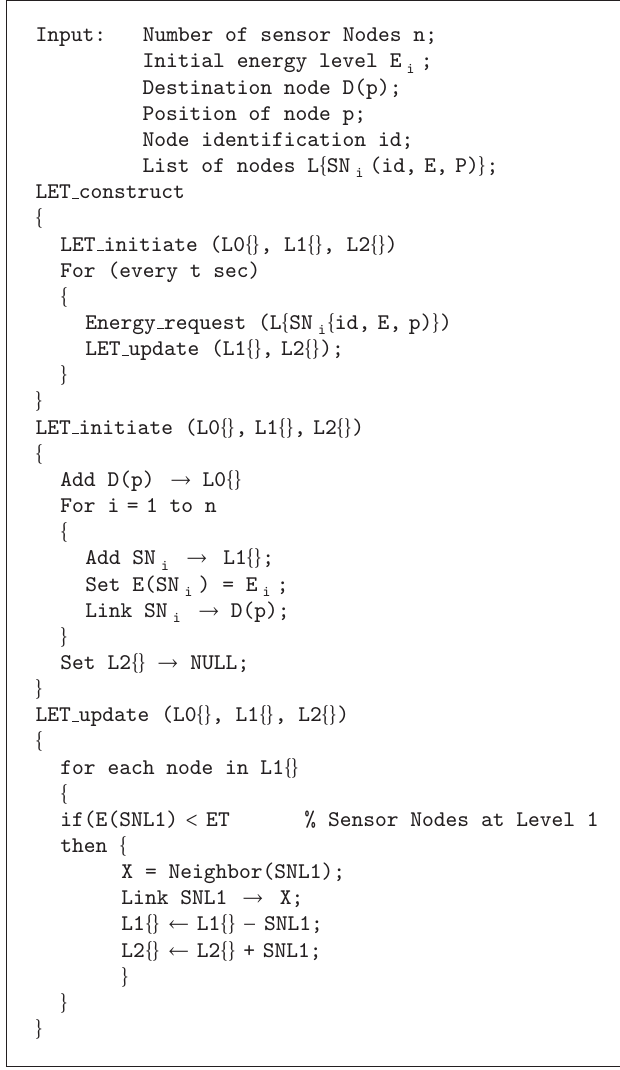
Algorithm 1: HET Construction Algorithm.